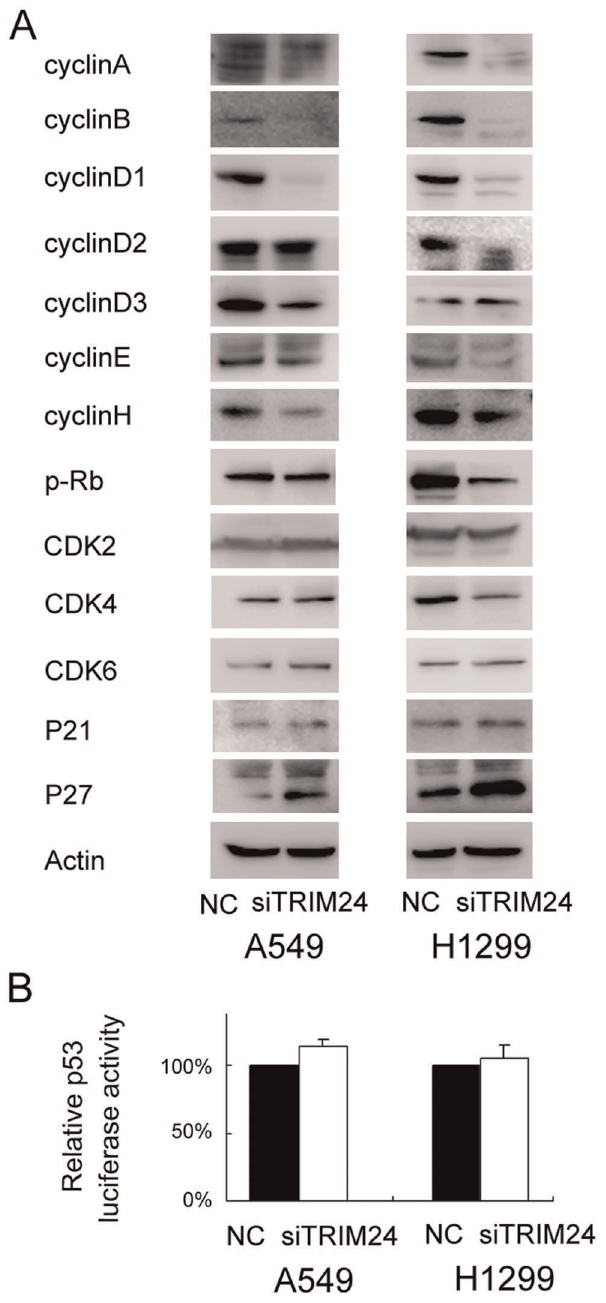
Figure 7. Expression of cell-cycle related molecules levels and p53 luciferase activity in TRIM24 depleted H1299 and A549 cells. Western blot analysis of a series of cell cycle related factors showed the protein levels of Cyclin A, B, D1, E and p-Rb were decreased and P27 expression was increased after silencing TRIM24 in H1299 and A549 cells (A). There was no significant change of p53 luciferase activity after siRNA treatment in both cell lines (B).